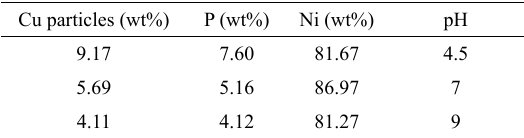
Figure 5. EDS analysis of the Ni-P-3 gr/lit composite coating. Table 11. The effect of pH on the weight percent of Ni, P and Cu particle in Ni-P-1(gr/lit) Cu